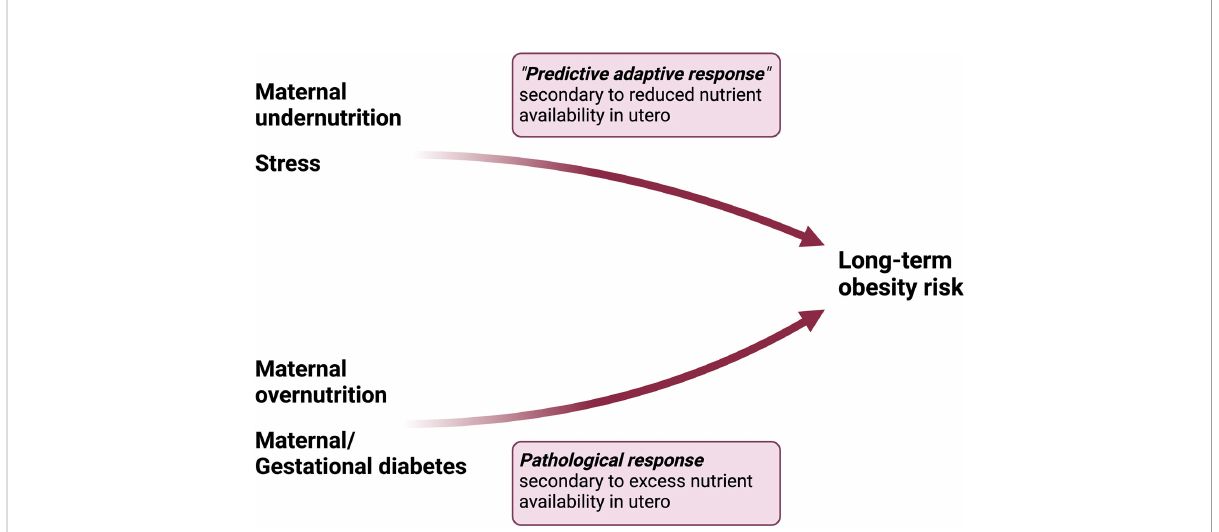
FIGURE 2 Differential pathways to obesity in response to maternal undernutrition vs overnutrition. Maternal undernutrition is hypothesized to condition obesity through a “ predictive adaptive response, ” in which the fetus programs its homeostatic set points in anticipation of persistent caloric de fi cit. However, the adaptive response becomes maladaptive in the setting of a mismatch between the anticipated environment and paradoxical exposures later in life. On the other hand, maternal overnutrition activates a pathological response in the fetus characterized by dysregulation in hormonal pathways involved in energy